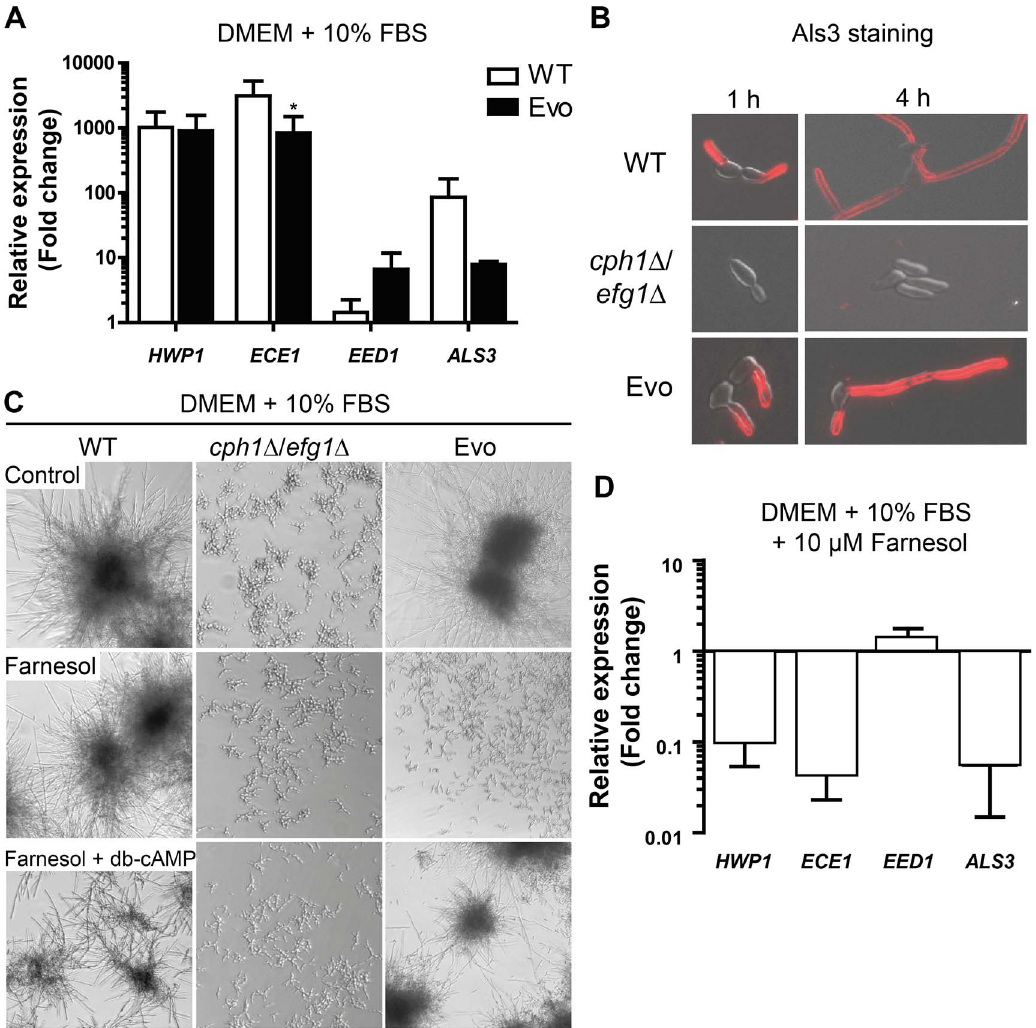
Fig. 3. Analysis of hyphae-associated gene expression, Als3 surface expression and response to farnesol. ( A ) The Evo strain expresses hyphae-associated genes after growth for 1 h at 37 u C at 5% CO 2 on a plastic surface similar to WT. Relative gene expression of filament-inducing conditions was compared to yeast promoting conditions (YPD, 30 u C) for three independent experiments. Expression was normalized against three housekeeping genes ( ACT1 , EFB1 and PMA1 ) and data are shown as mean + SD of three biological experiments (*p , 0.05). ( B ) Immunofluorescence micrographs of cells immuno-stained for Als3 after growth in DMEM + 10% FBS at 37 u C and 5% CO 2 on cover slips. Wild type (WT) and Evo cells are Als3-positive, while cph1 D / efg1 D cells show no signal (representative samples). ( C ) Morphogenetic response to farnesol treatment alone or in combination with exogenous dibutyryl-cyclic AMP (db-cAMP). All strains were exposed to either methanol (control), 1 m M farnesol or 1 m M farnesol + 10 mM db-cAMP and incubated at 37 u C and 5% CO 2 for 18 h (representative pictures from three independent experiments are shown). Note that in Evo cells inhibition of filamentation by farnesol treatment was completely abrogated when db-cAMP was added. ( D ) Repression of hyphae-associated gene expression in the Evo strain by 10 m M farnesol. Expression was normalized against three housekeeping genes ( ACT1 , EFB1 and PMA1 ). The fold change in expression relative to filament-inducing conditions alone is shown as mean + SD of three biological experiments. compared to the wild type strain. The Evo strain showed an intermediate mannan and wild type-like glucan exposure. The two MAP kinases, Cek1 and Mkc1, become activated in wild type C. albicans upon treatment with cell wall disturbing agents [34–36]. After treatment with CR, both Cek1 and Mkc1 were phosphorylated in the Evo strain but not in the cph1 D / efg1 D strain (Fig. 5C). Unusually, only phosphorylated Mkc1 could be detected in the wild type strain, which may be due to changes in the CR treatment protocol compared to previous experiments performed by another group [34]. However, these results show that the Evo strain regained the ability to phosphorylate Mkc1 and nuclear RNAs and for 24 tRNAs (see Materials and Methods for details and S2 Table for a complete list of all detected transcripts). Cek1 in response to cell wall stress.